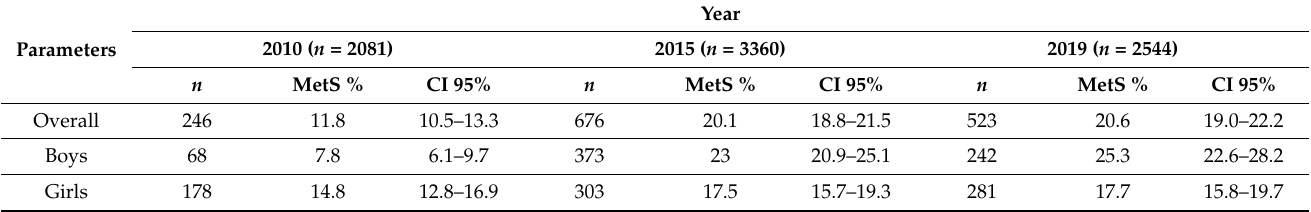
Table 2. Prevalence of MetS in the 2010, 2015, and 2019 cohort.